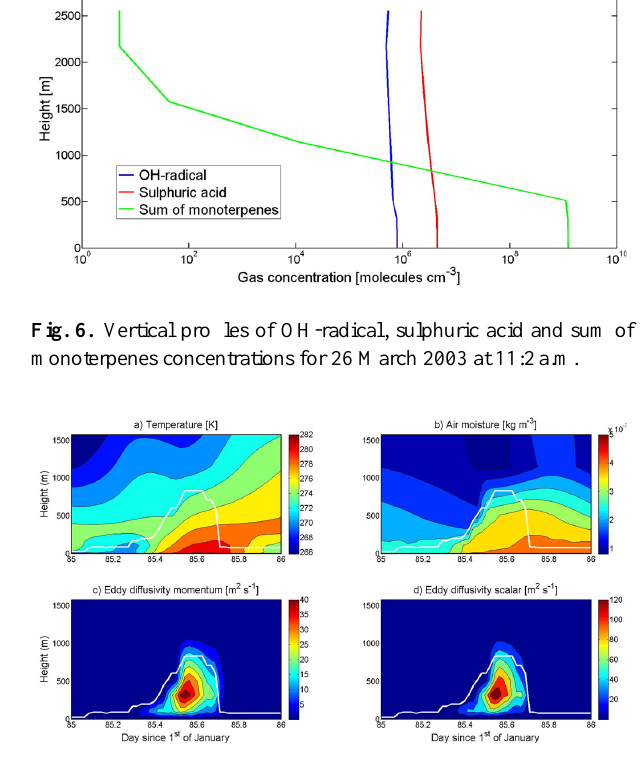
Fig. 7. Modelled vertical profiles of temperature, air moisture and eddy diffusivity for momentum and scalar for 26 March 2003. The simulated evolution of the atmospheric boundary layer height esti- mated as the level with Ri =0.25 is included by white